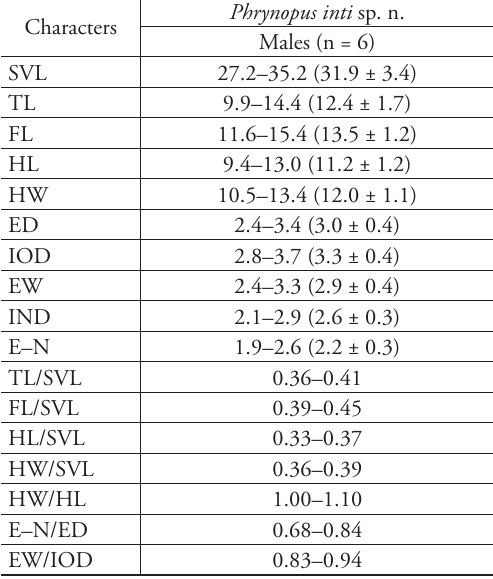
Table 4. Measurements (in mm) and proportions of male type specimens of Phrynopus inti sp. n.; ranges followed by means and one standard deviation in parentheses. For abbreviations see materials and